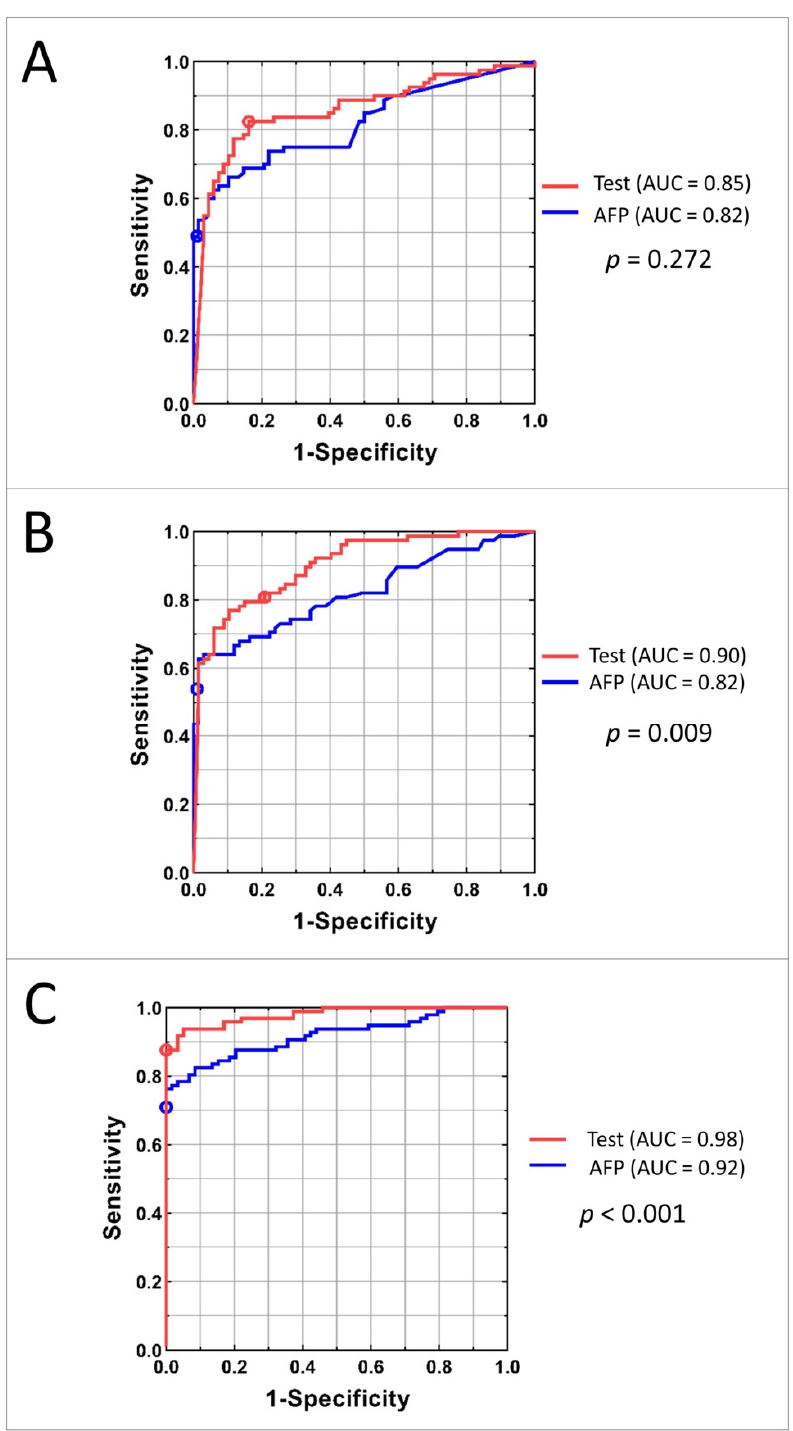
Figure 4. AUC curves for Development ( A ), Internal Validation ( B ), and Independent Validation ( C ) sets. Red line represents the family of tests obtained by adjusting the cutoff of the classifier; the red circle shows the results for the test with specified cutoff. Blue line corresponds to the classification using AFP concentration; blue circle shows the results for the AFP cut-off 20 ng/mL. The similarity of AUCs between the Development and Internal Validation sets indi- cates excellent generalization of classification performance. Increased performance in the Independent Validation set is likely due to the differences in population. The test showed